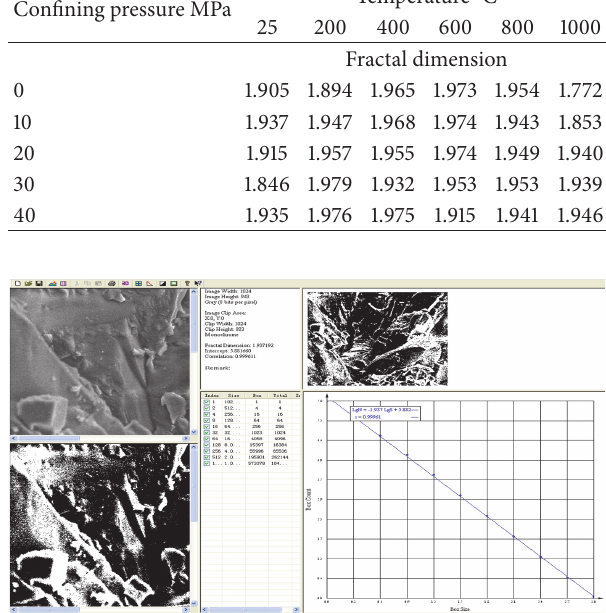
Figure 1: Calculation software of fractal